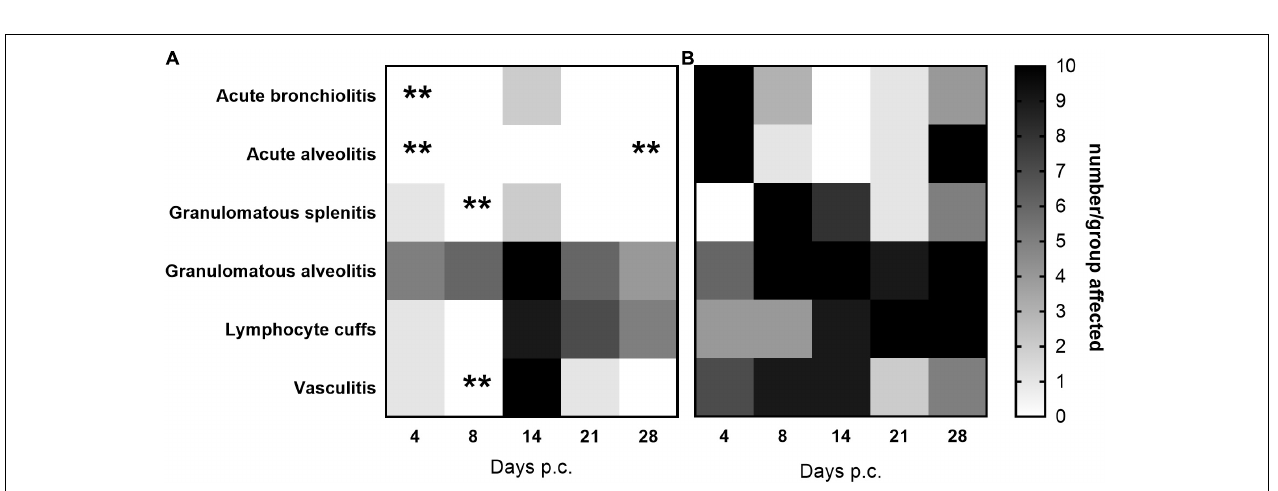
FIGURE 5 | The occurrence of typical histopathological features associated with C. burnetii in lung and spleen tissues. At 24 h post-challenge mice were treated with (A) finafloxacin (30 mg/kg) or (B) the carrier, orally daily for 7 days. Tissues were taken on days 4, 8, 14, 21, and 28 p.c. and scored for the presence/absence of 6 typical histopathological features associated with murine Q fever, and the occurrence displayed as a heat map (where white is no animal affected and black is all 10 affected). ** p < 0.01.